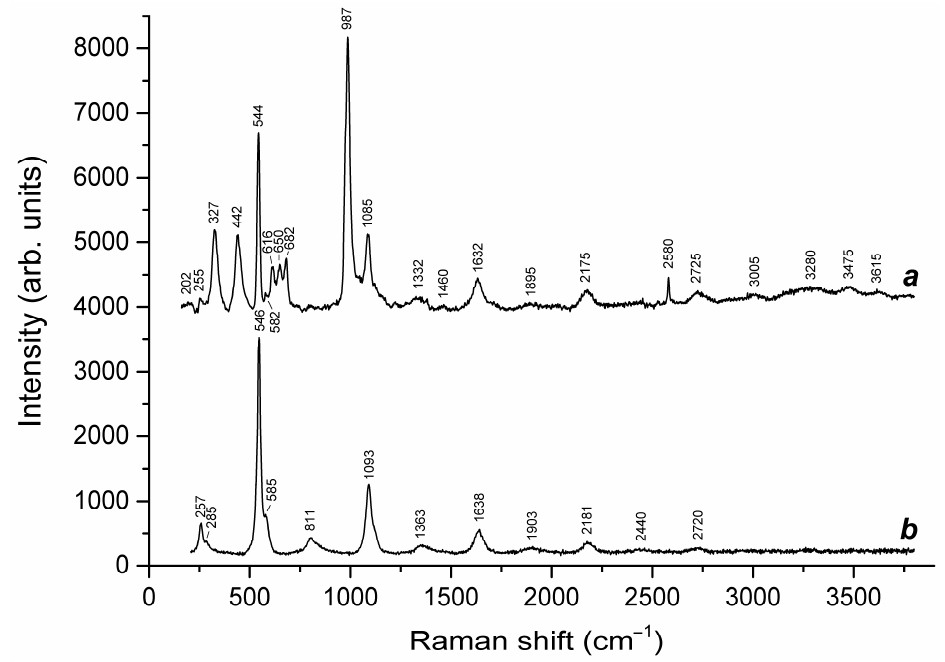
Figure 1. Raman spectra of ( a ) S 4 -bearing haüyne (Sample 1) and ( b ) lazurite (Sample 9).